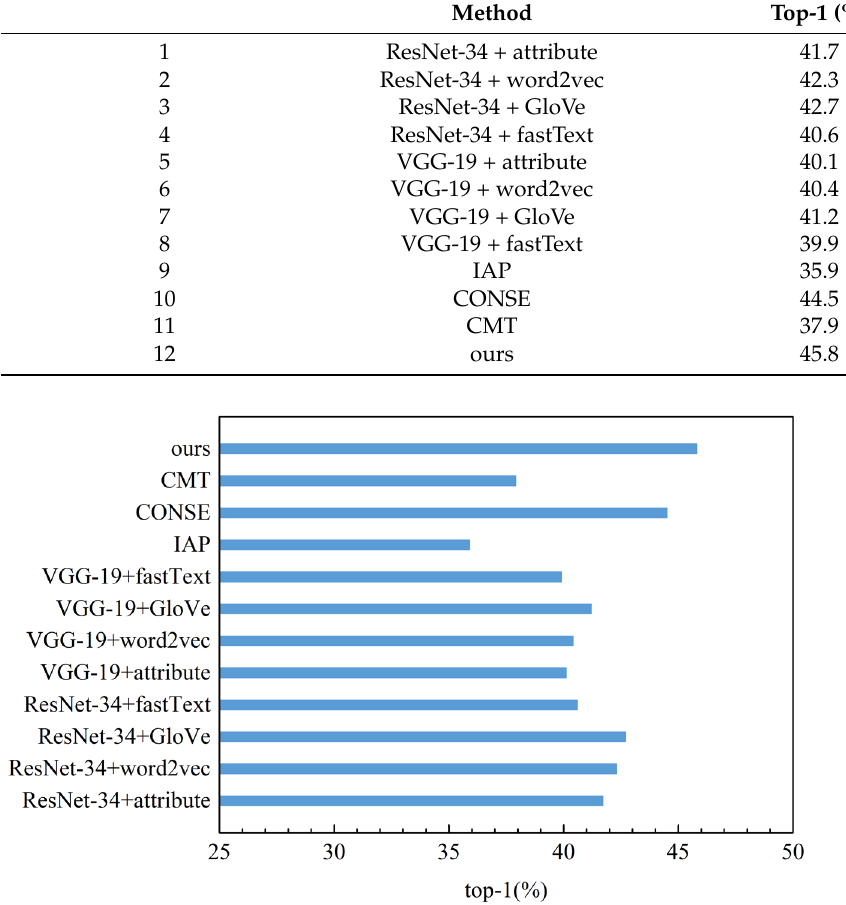
Figure 7. Top-1 accuracy comparison of different methods.